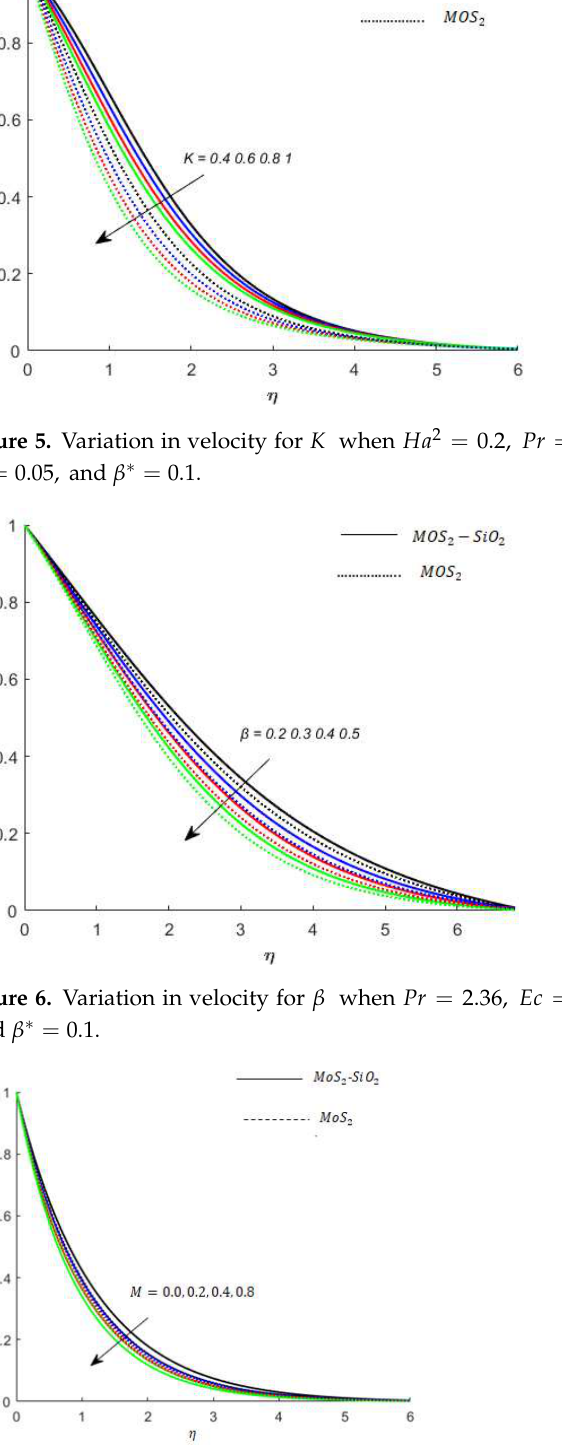
Figure 8. Variation in temperature for 𝑀 when 𝑃𝑟 = 2.36,𝐸𝑐 = 0.01,𝑆𝑐 = 0.8,(𝐺𝑟) (cid:3030) = 0.1,𝐾 = 0.1,𝐵𝑖 = 0.05,𝛽 ∗ = 0.1,and 𝑆𝑟 = 0.1. Figure 9. Variation in temperature for 𝐸𝑐 when 𝑀 = 0.2, 𝑃𝑟 = 2.36,𝑆𝑟 = 0.1,𝑆𝑐 = 0.8, (𝐺𝑟) (cid:3030) = 0.1,𝐾 = 0.1,𝐵𝑖 = 0.05,𝑎𝑛𝑑 𝛽 ∗ = 0.1 .